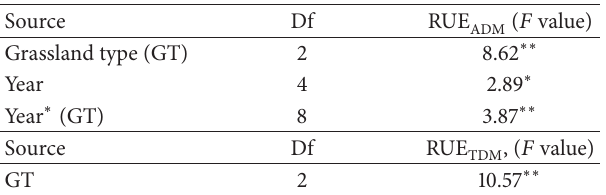
Table2: 𝐹 valuesandtheprobabilityofANOVAanalysisofRUE ADM and RUE TDM